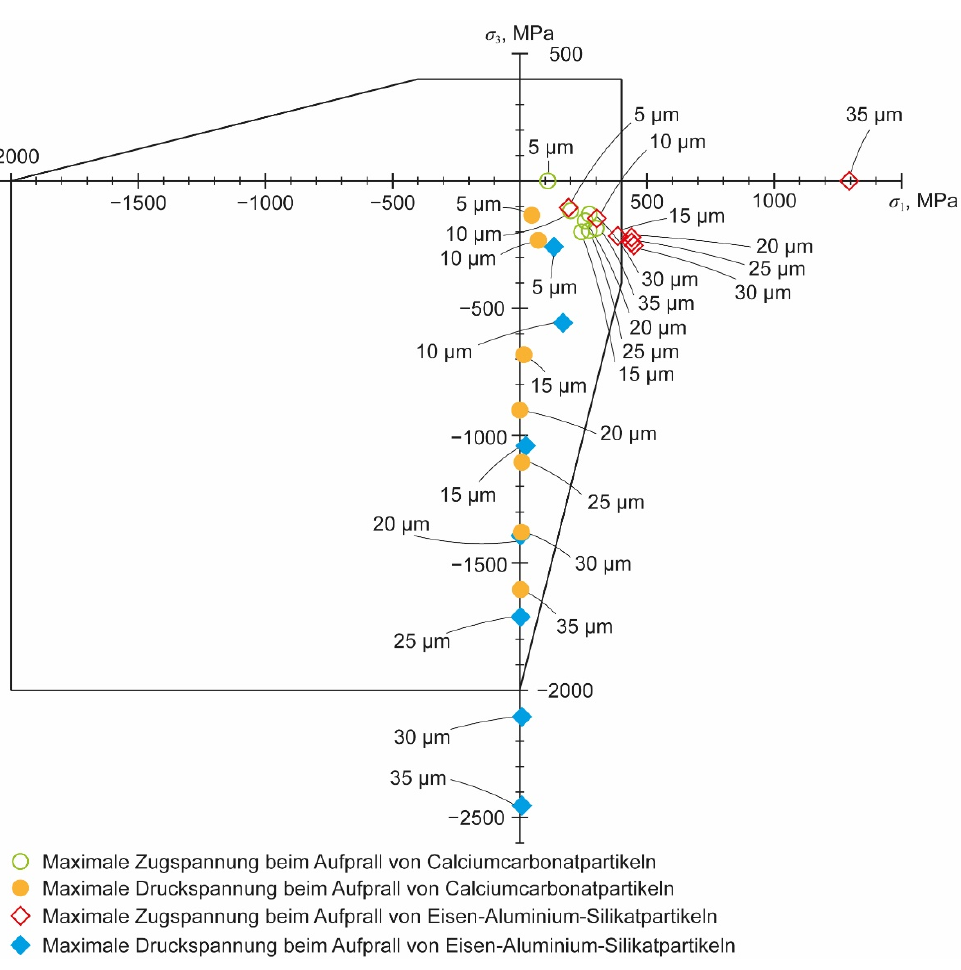
Figure 16. The failure envelope at the impact of calcium carbonate (circles) and iron–aluminum– silicate (diamonds) particles with different diameters at an operating pressure of 300 MPa on the surface of a c-axis aligned sapphire. The values are derived from an explicit dynamic numerical calculation; the two principal stresses for the plane stress state at the times of the highest compressive stress (full symbols) and the highest tensile stress (outlined symbols) are shown.